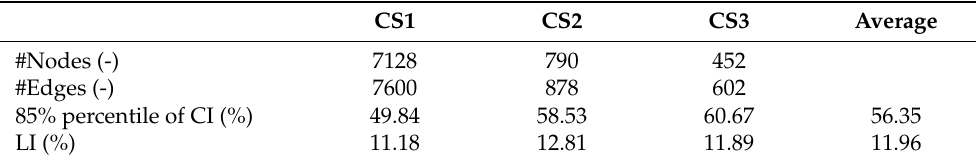
Table 5. Results of the graph analysis for water supply networks.